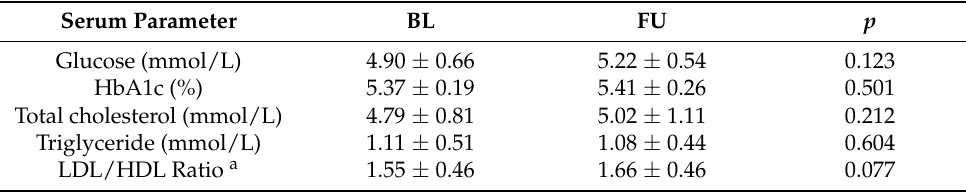
Table 2. Fasting serum parameters ( N = 17). Serum